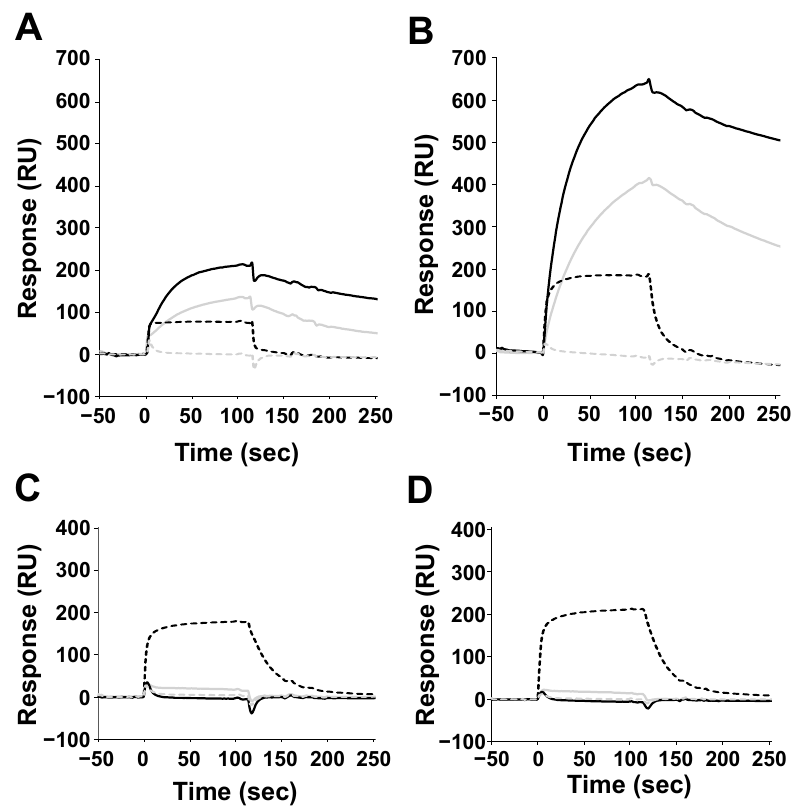
Figure 2. Binding of SLAM proteins to measles virus (MV) and CDV-H from the wild-type and vaccine strain. Human (gray solid line), tamarin (solid line), dog (broken line), and mouse SLAM (gray broken line) were injected for 120 s through flow cells bound with ( A ) MV-Hwt (641 RU), ( B ) MV-Hvac (1651 RU), ( C ) CDV-Hwt (574 RU), and ( D ) CDV-Hvac (776 RU). As a negative control, the response of HLA-G immobilized flow cells was subtracted.